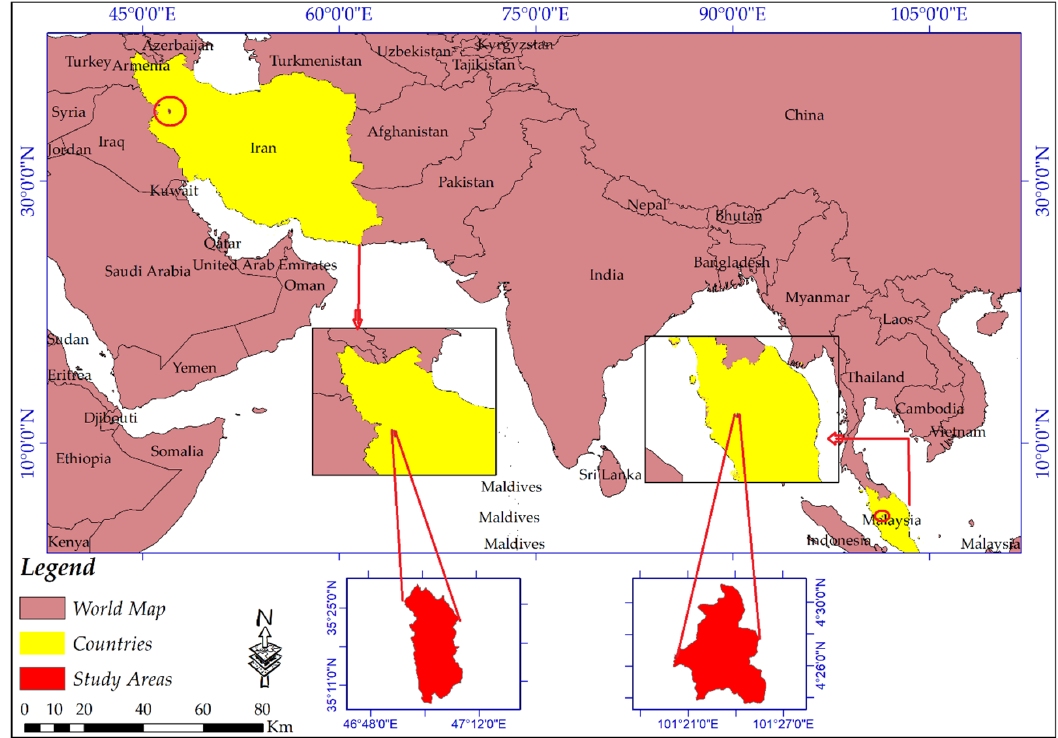
Figure 1. The geographical extent of the study areas.